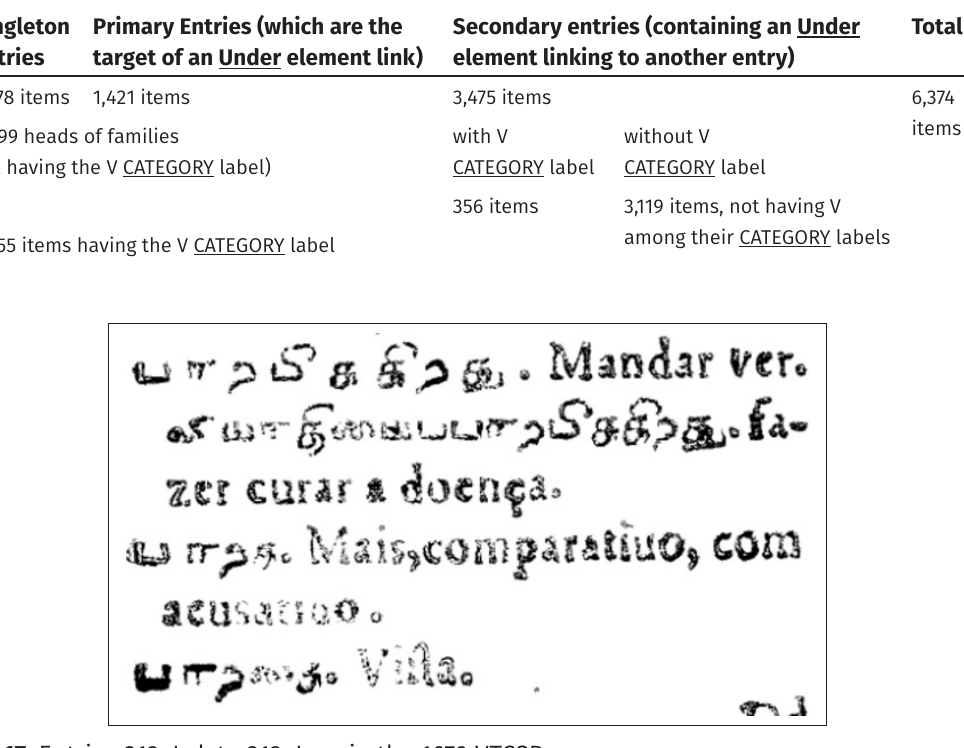
Figure 17: Entries 213_L_k to 213_L_m in the 1679